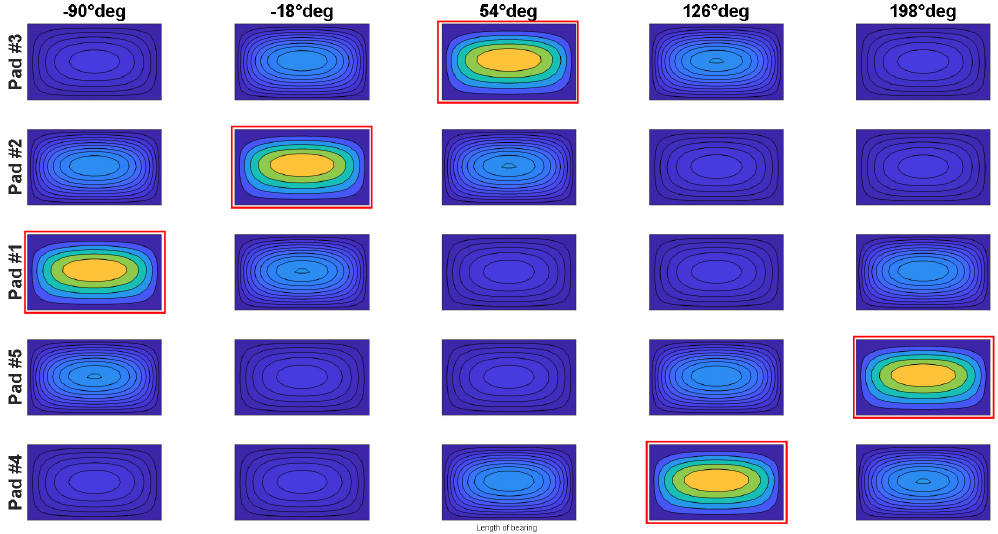
Figure 23. Predicted pressure distribution with LOP configuration of nominal bearing.